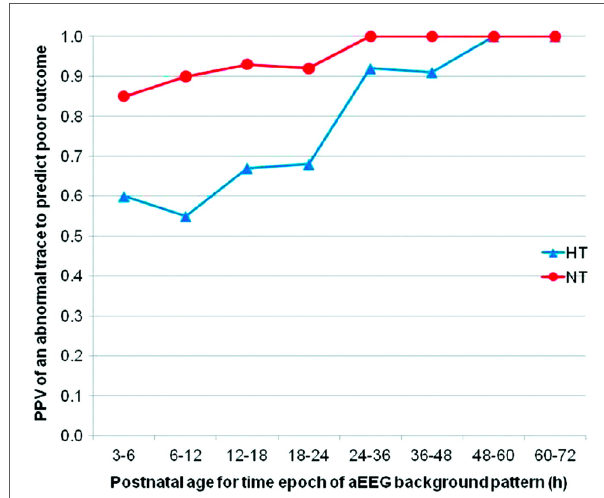
FIGURE 3 The PPV for an abnormal tracing to predict adverse outcome. HT=hypothermia and NT=normothermia. Abnormal tracing Is de fi ned as burst suppression, low voltage or fl at tracing and adverse outcome Is de fi ned as death or Either Bayley Scales of Infant Development Mental Developmental Index <70, gross motor classi fi cation level 3-5 or No useful vision.(reproduced with permission from thoresen M, hellström-westas L, Liu X, de Vries LS. Effect of hypothermia on amplitude-integrated electroencephalogram in infants with asphyxia. Pediatrics. 2010